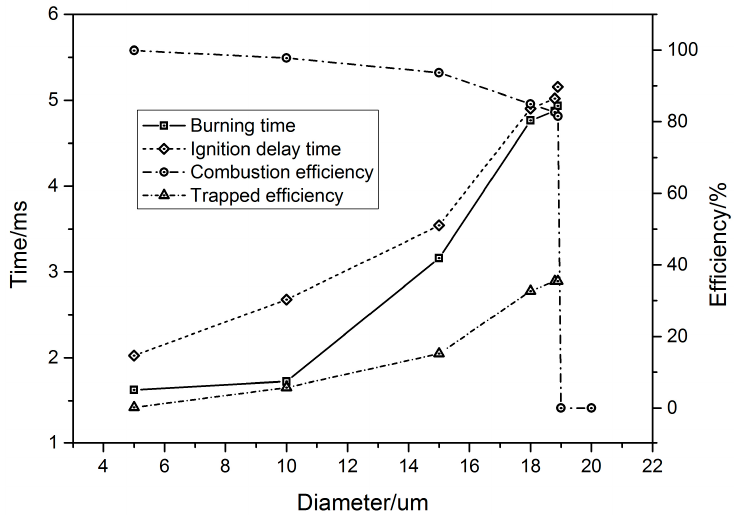
Figure 13. Distribution of combustion efficiency, ignition delay time, burning time and trapped efficiency for different particle sizes.